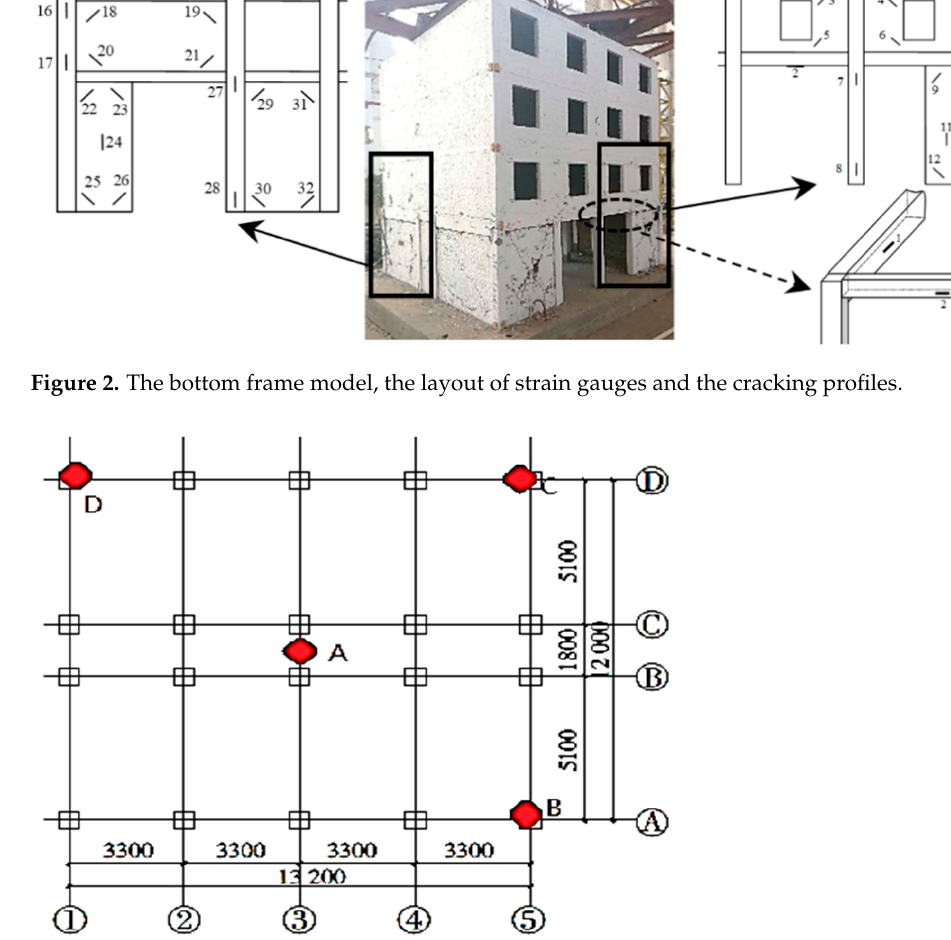
Figure 3. The layout of accelerators and displacement meters.